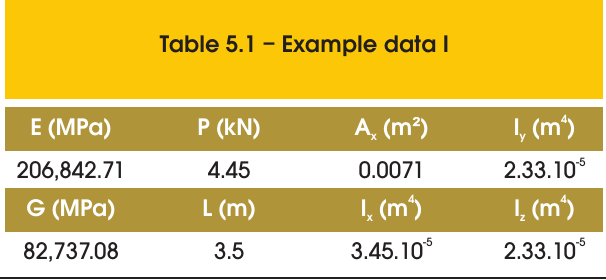
Table 5.1 – Example data